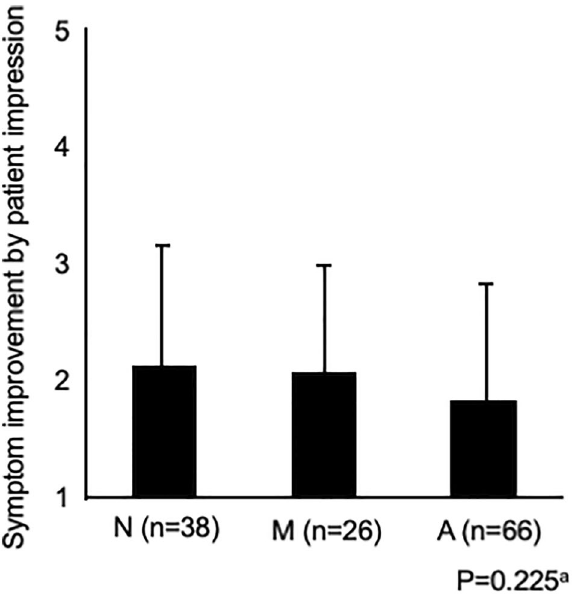
Figure 3. Comparison of symptom improvement among the three groups after 4 weeks of proton pump inhibitor administration: Symptom improvement through patient impressions. NOTE: a = analysis of variance.